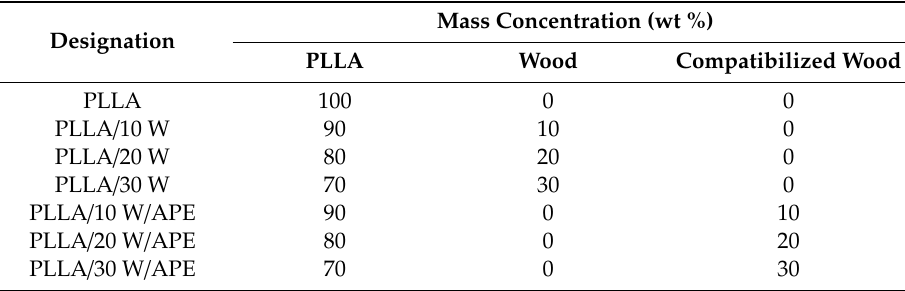
Table 1. Symbols and mass concentrations of